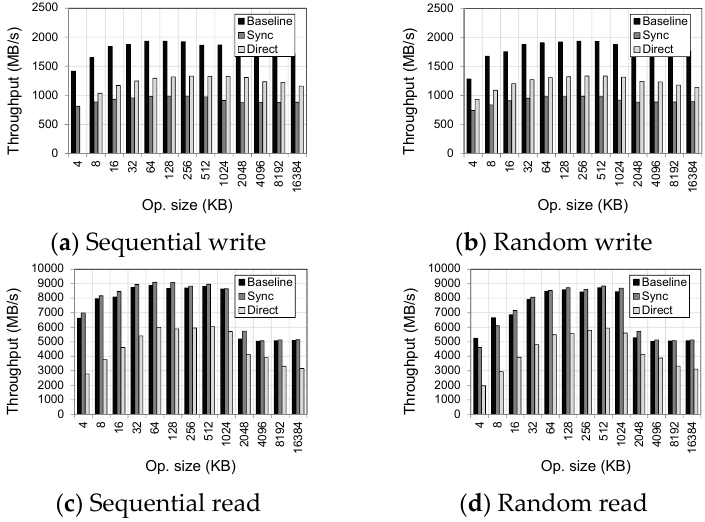
Figure 4. PCMdisk performance under different I/O modes.